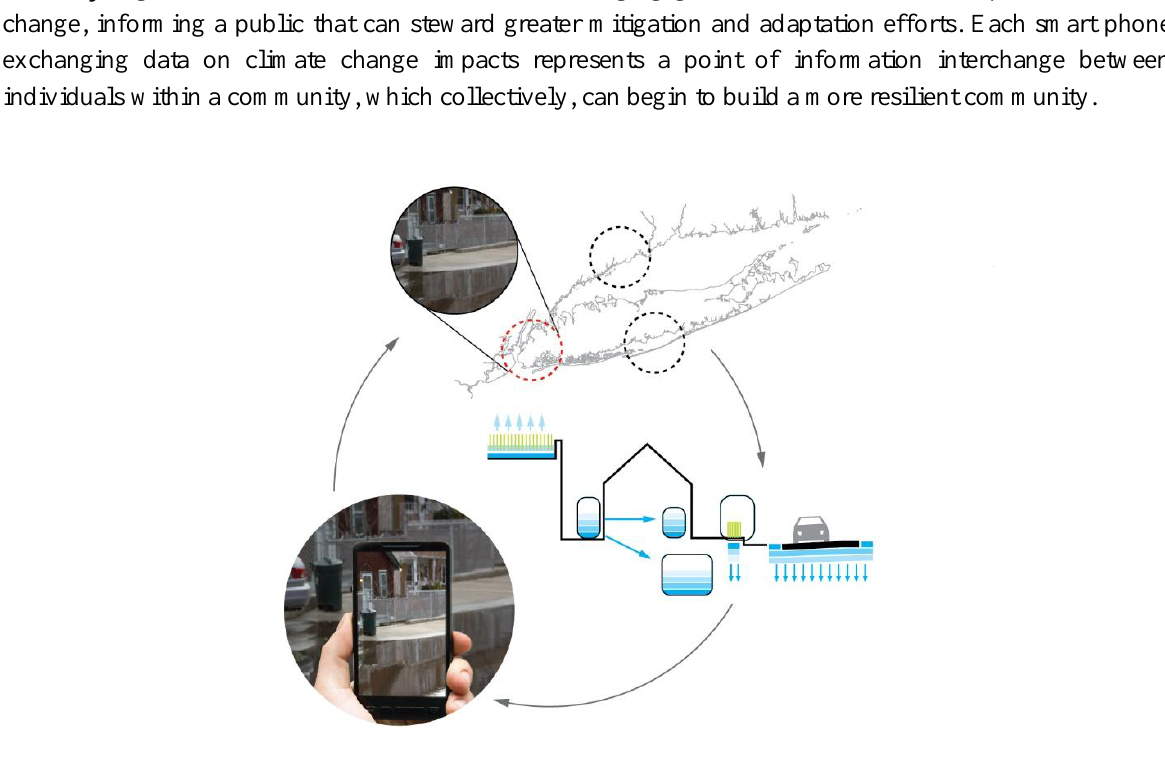
Figure 2. PoroCity Conceptual